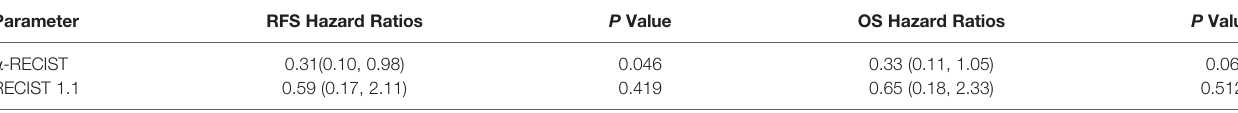
Data in parentheses are 95%